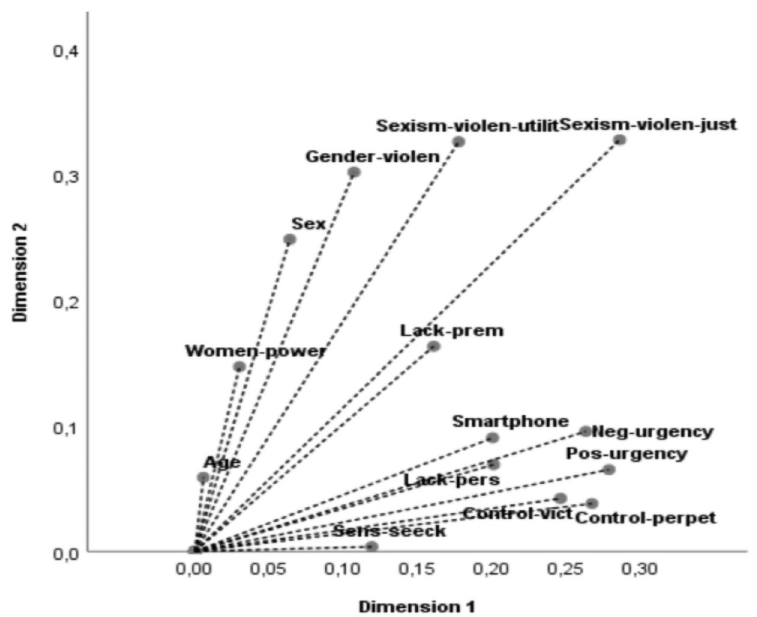
Fig 1. Discrimination indices of the variables for D1 and D2. � Variables and abbreviations: (a) Problematic smartphone usage = smartphone; (b) Sexist beliefs and violence justification = sexism-violen-just; (c) beliefs about the utility of sexism and violence = sexism-violen-utilit; (d) Conceptualization of gender violence as inevitable and private = gender-violen; (e) Perception of women’s access to power and responsibility = women-power; (f) Negative urgency = neg-urgency; (g) Positive urgency = pos-urgency; (h) Sensation seeking = sen-seeck; (i) Lack of premeditation = lack-prem; (j) Lack of perseverance = lack-pers; (k) Victim of control = control-vict; (l) Perpetrator of control = control-perpet.